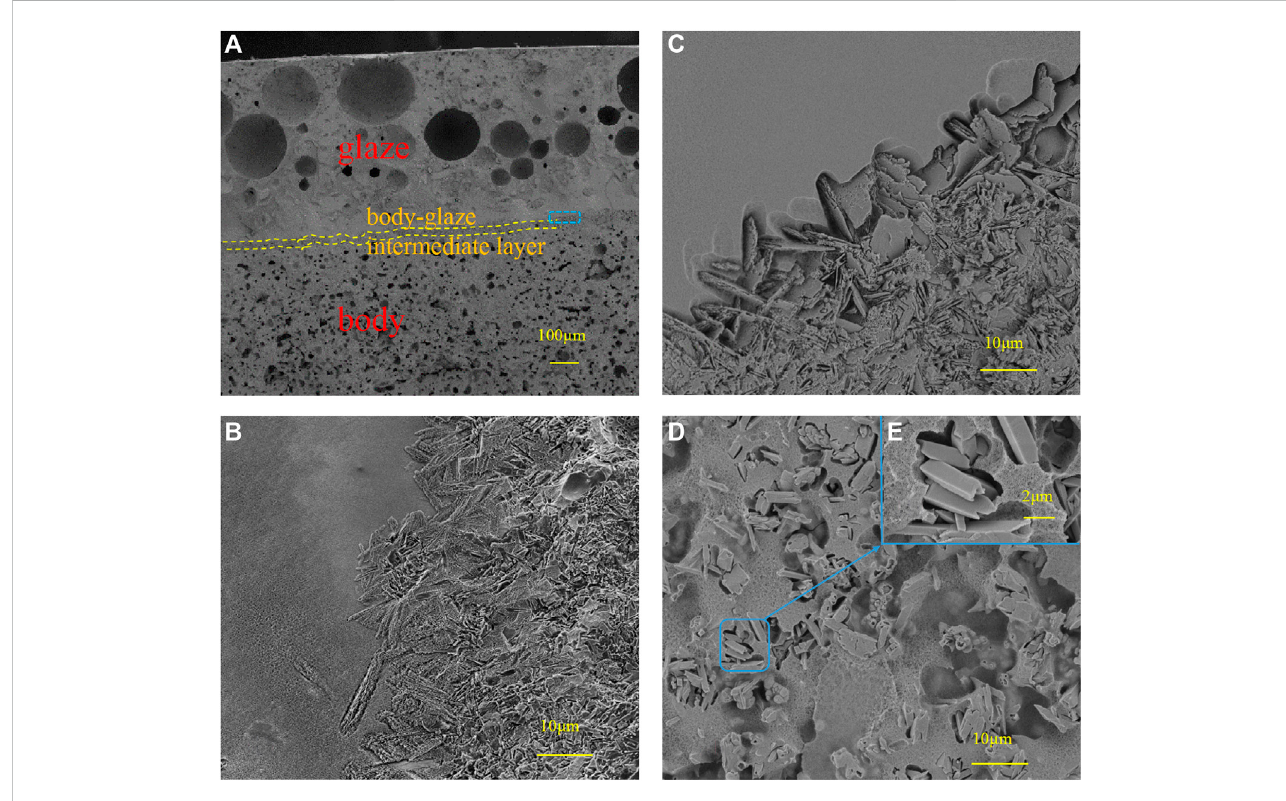
FIGURE 5 The SEM micrographs of the section (A – C) and glaze surface (D,E) of sample GFA2.